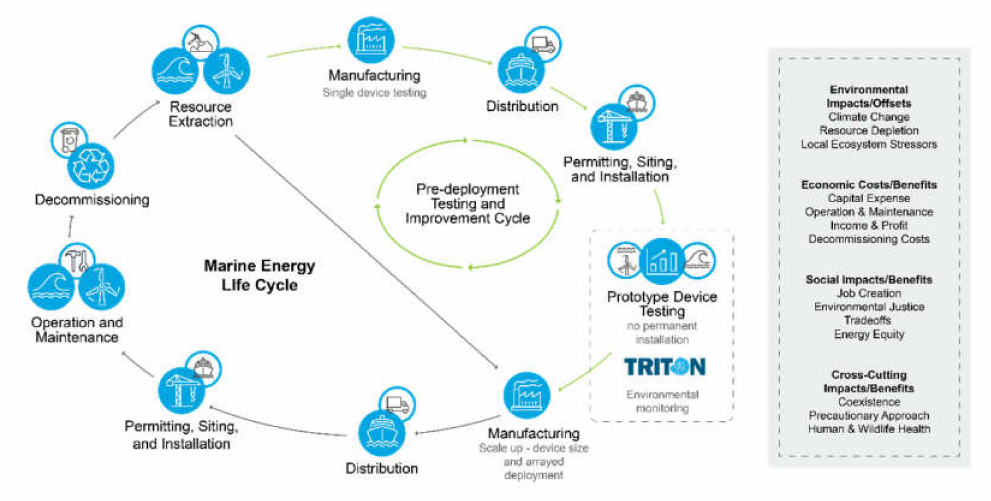
Figure 4. The life cycle of marine energy (ME) technology, including the pre-deployment testing and improvement cycle, with example environmental, economic, social, and cross-cutting impacts and benefits. By including a pre-deployment testing and improvement cycle in the ME life cycle, unintended consequences and tradeoffs can be identified, mitigated, and avoided (illustration by Stephanie King,